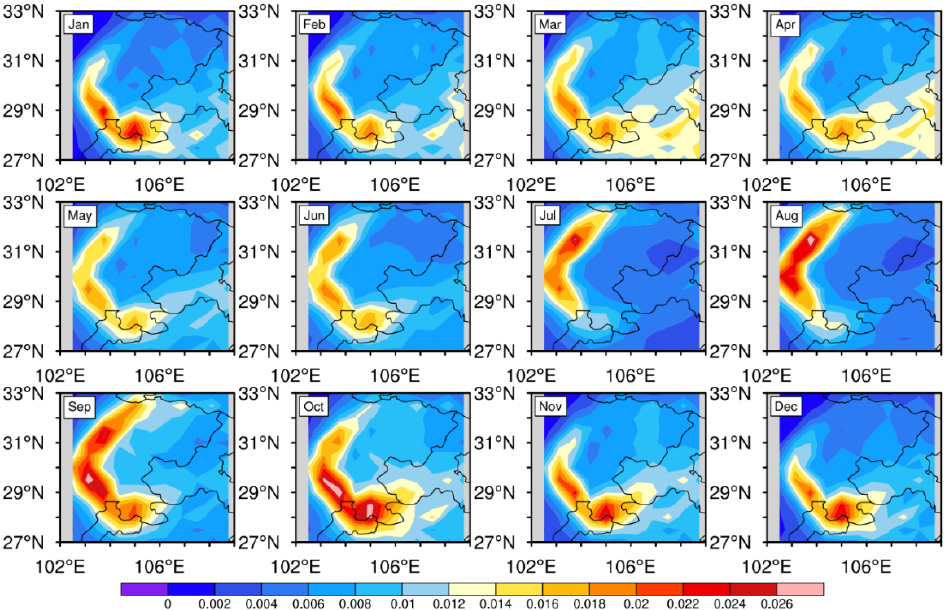
Figure 6. Spatial distribution of monthly variations of black carbon wet deposition flux over the Sichuan Basin during 1981–2020. Unit: μg m −2 s −1 .